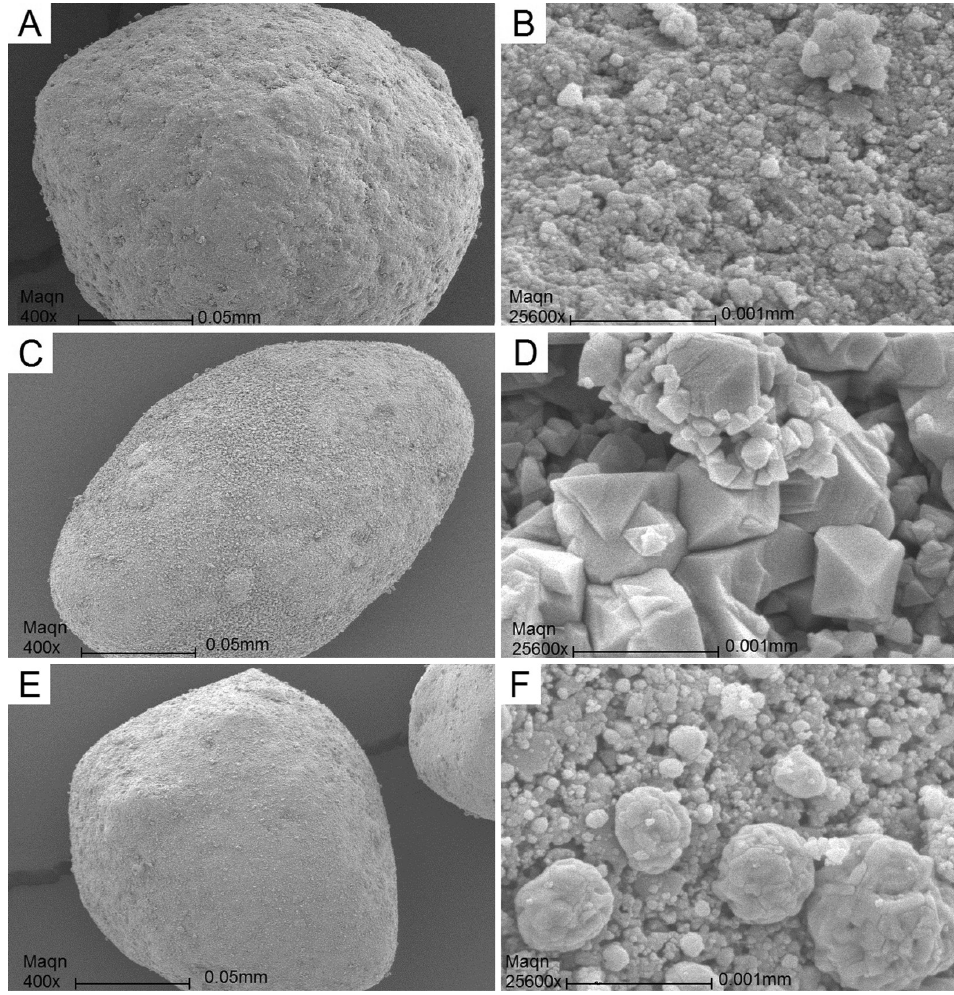
Figure 5. SEM micrographs of oxidised NiO/NiAl at high magnification (25600x). A and B (Before reactivity test), C and D (after reactivity tests with procedure 1), E and F (after reactivity tests with procedure